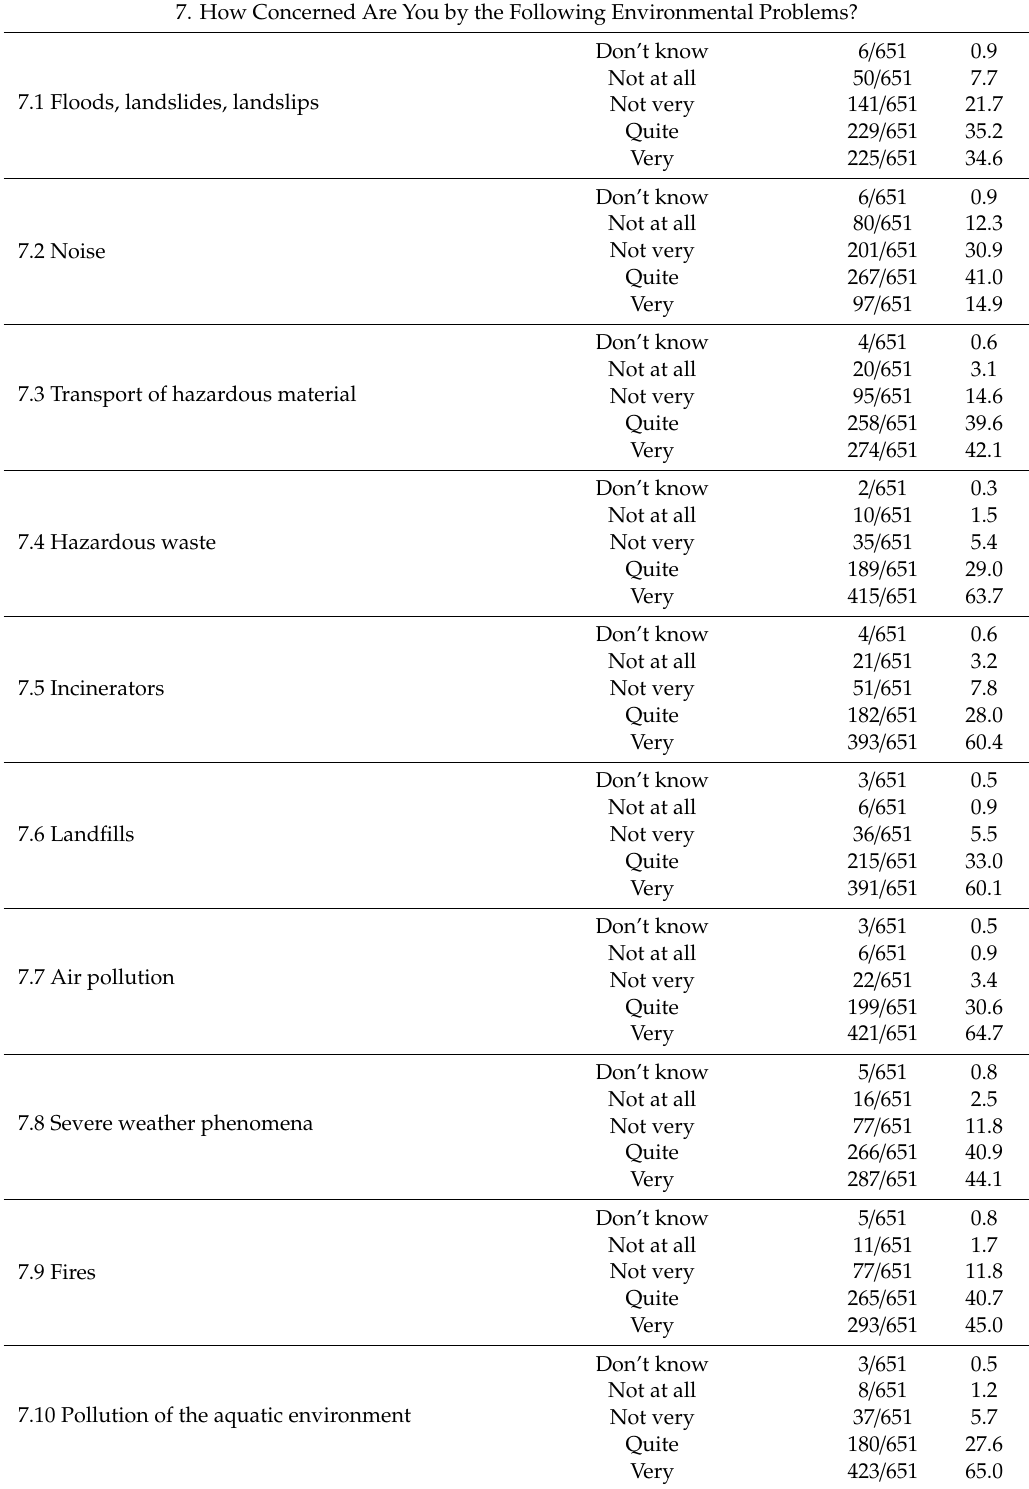
Table 4. Questionnaire items and sub-items and descriptive